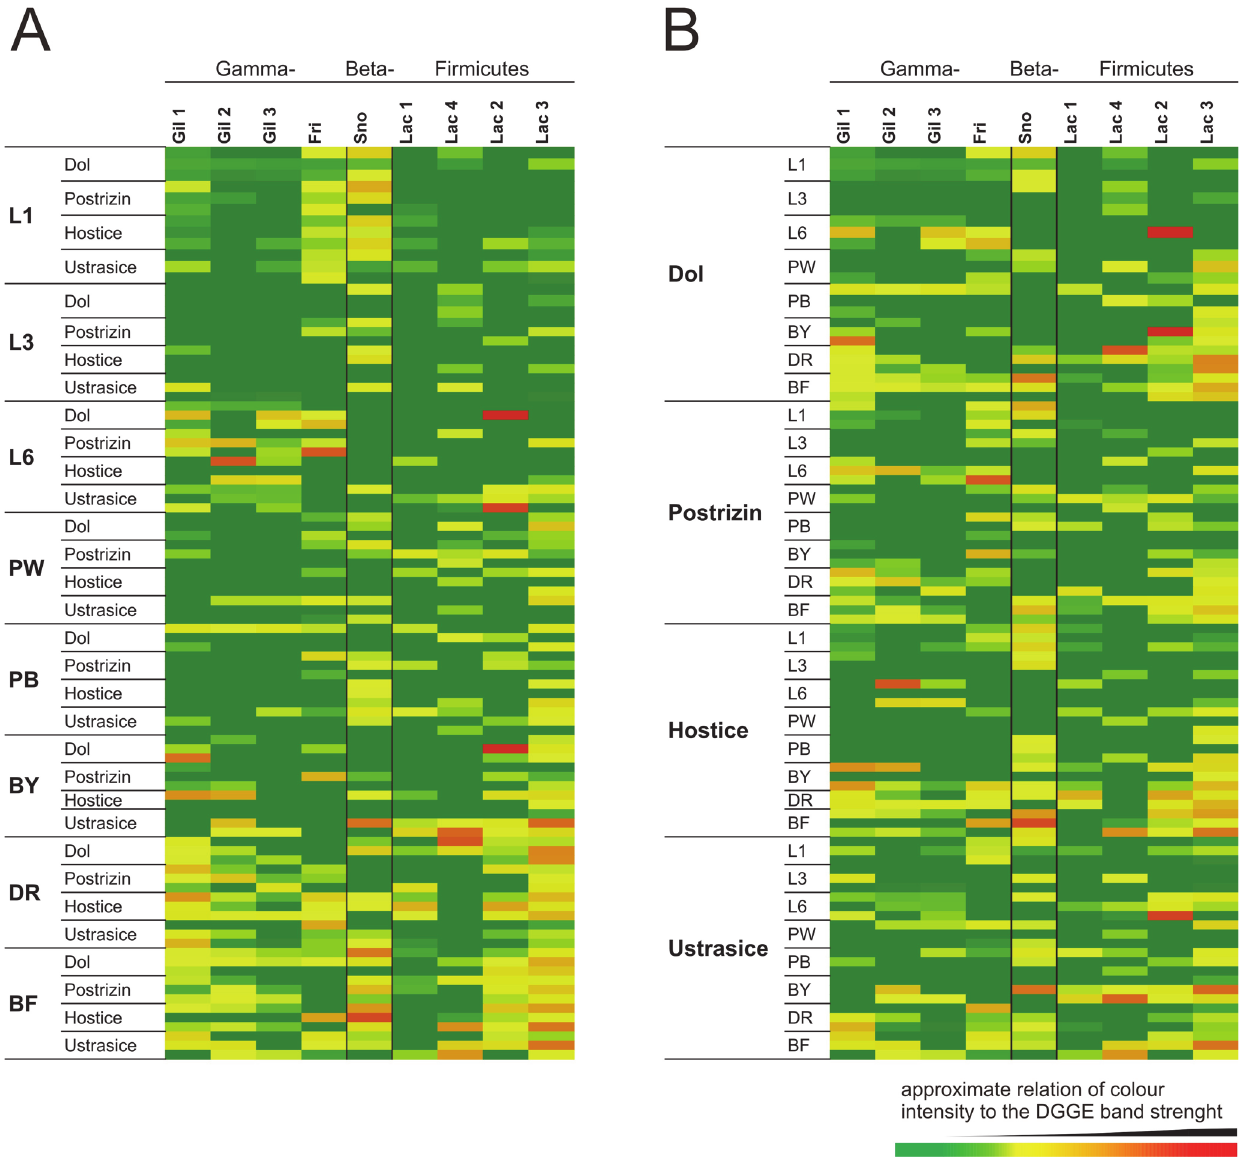
Fig 1. Heatmap summarising the relative density of dominant denaturing electrophoresis bands of the 16S rRNA amplicon profiles of the total gastrointestinal tract contents of several honey bee ontogenetic stages. 1-, 3- and 6-day old larvae (L1, L3 and L6, respectively), white and black pupae (PW, PB), young bees, drones and flying bees (BY, DR and BF, respectively) collected in 4 different locations (Dol, Postrizin, Ustrasice, Hostice). Samples are sorted by ontogenetic stage (A) and location (B). The colours refer to relative band strength according to the colour